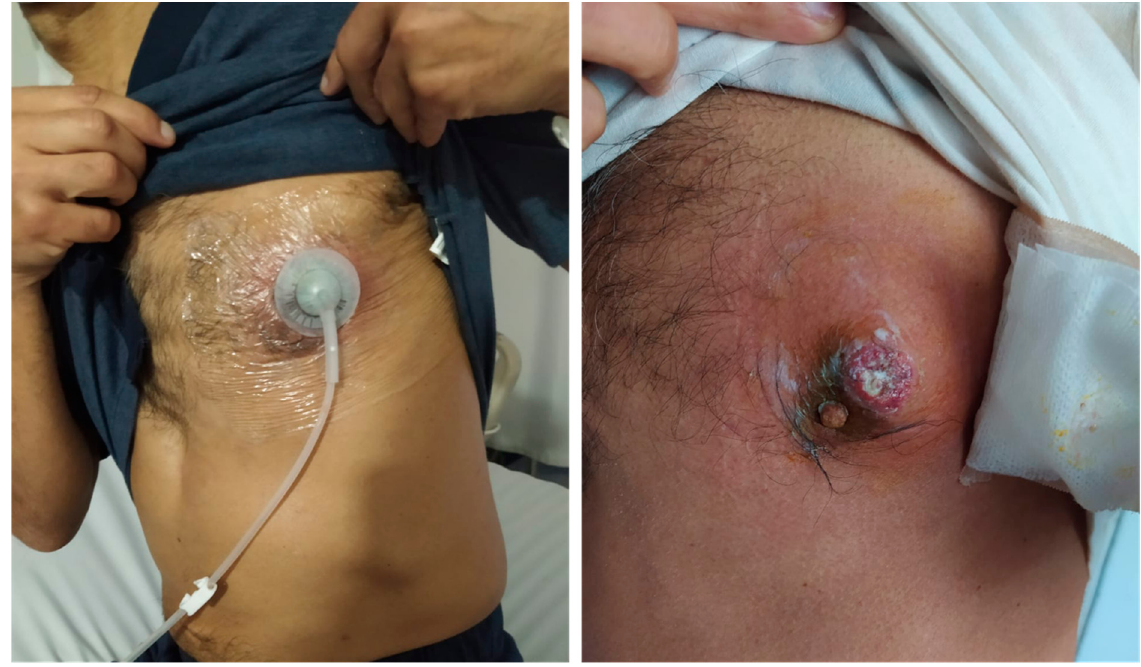
Figure 3. Lesion evolution at discharge, after antibiotic and negative pressure therapy.